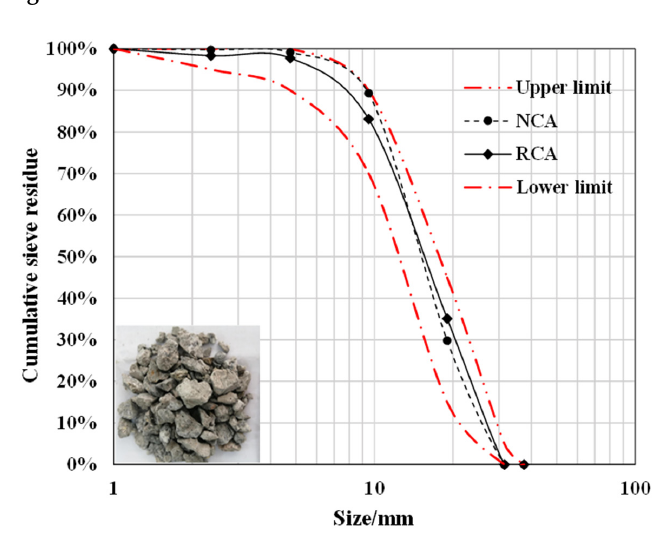
Figure 2. Gradation curve of concrete.